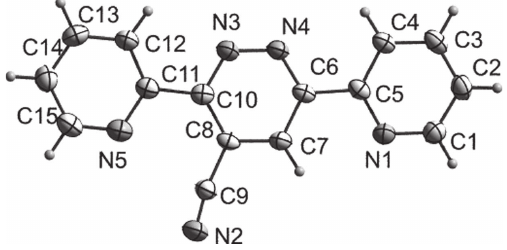
Table 1: Data collection and handling.